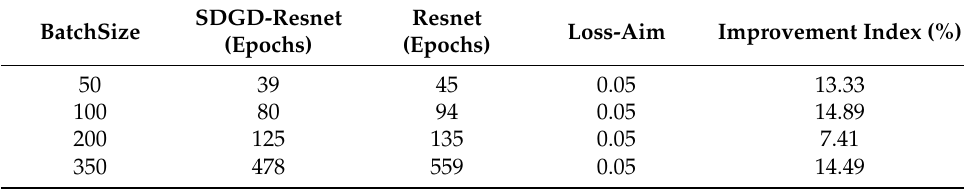
Table 4. Convergence speed comparison.